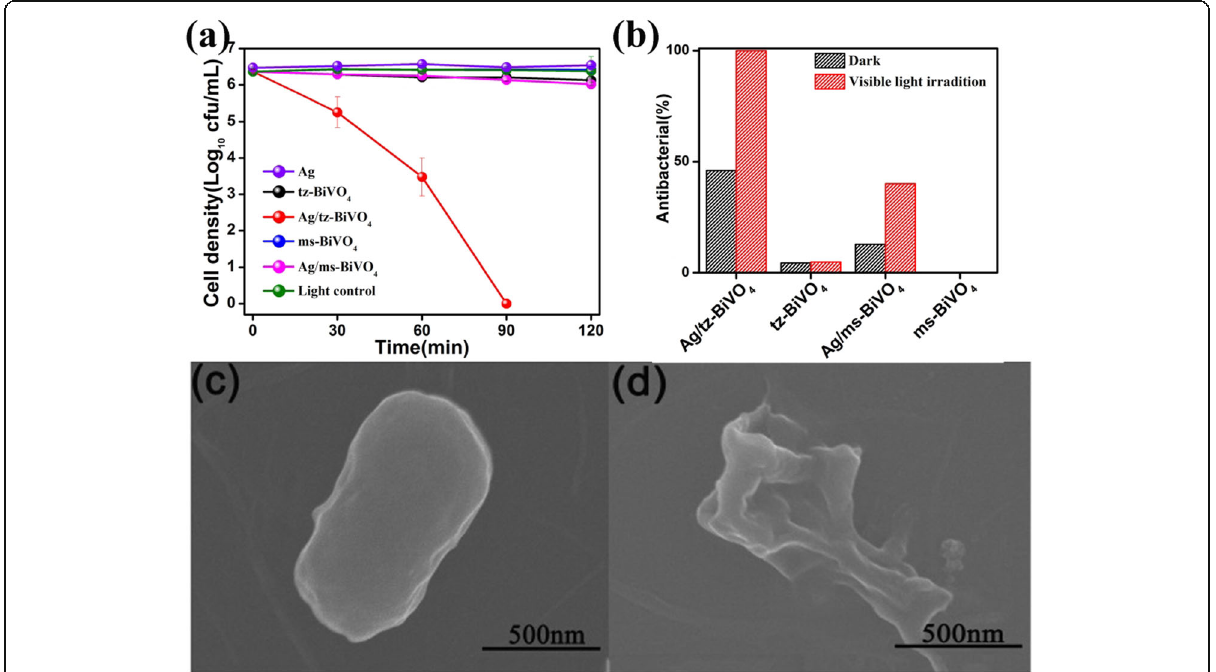
Fig. 5 Photocatalytic inactivation of E. coli by Ag/tz-BiVO 4 and Ag/ms-BiVO 4 photocatalysts under VL irradiation ( a ). Comparison study of photocatalytic and thermocatalytic sterilization effect ( b ). SEM images of individual E. coli cell being photocatalytically inactivated by Ag/tz-BiVO 4 for 0 h ( c ) and 2 h ( d